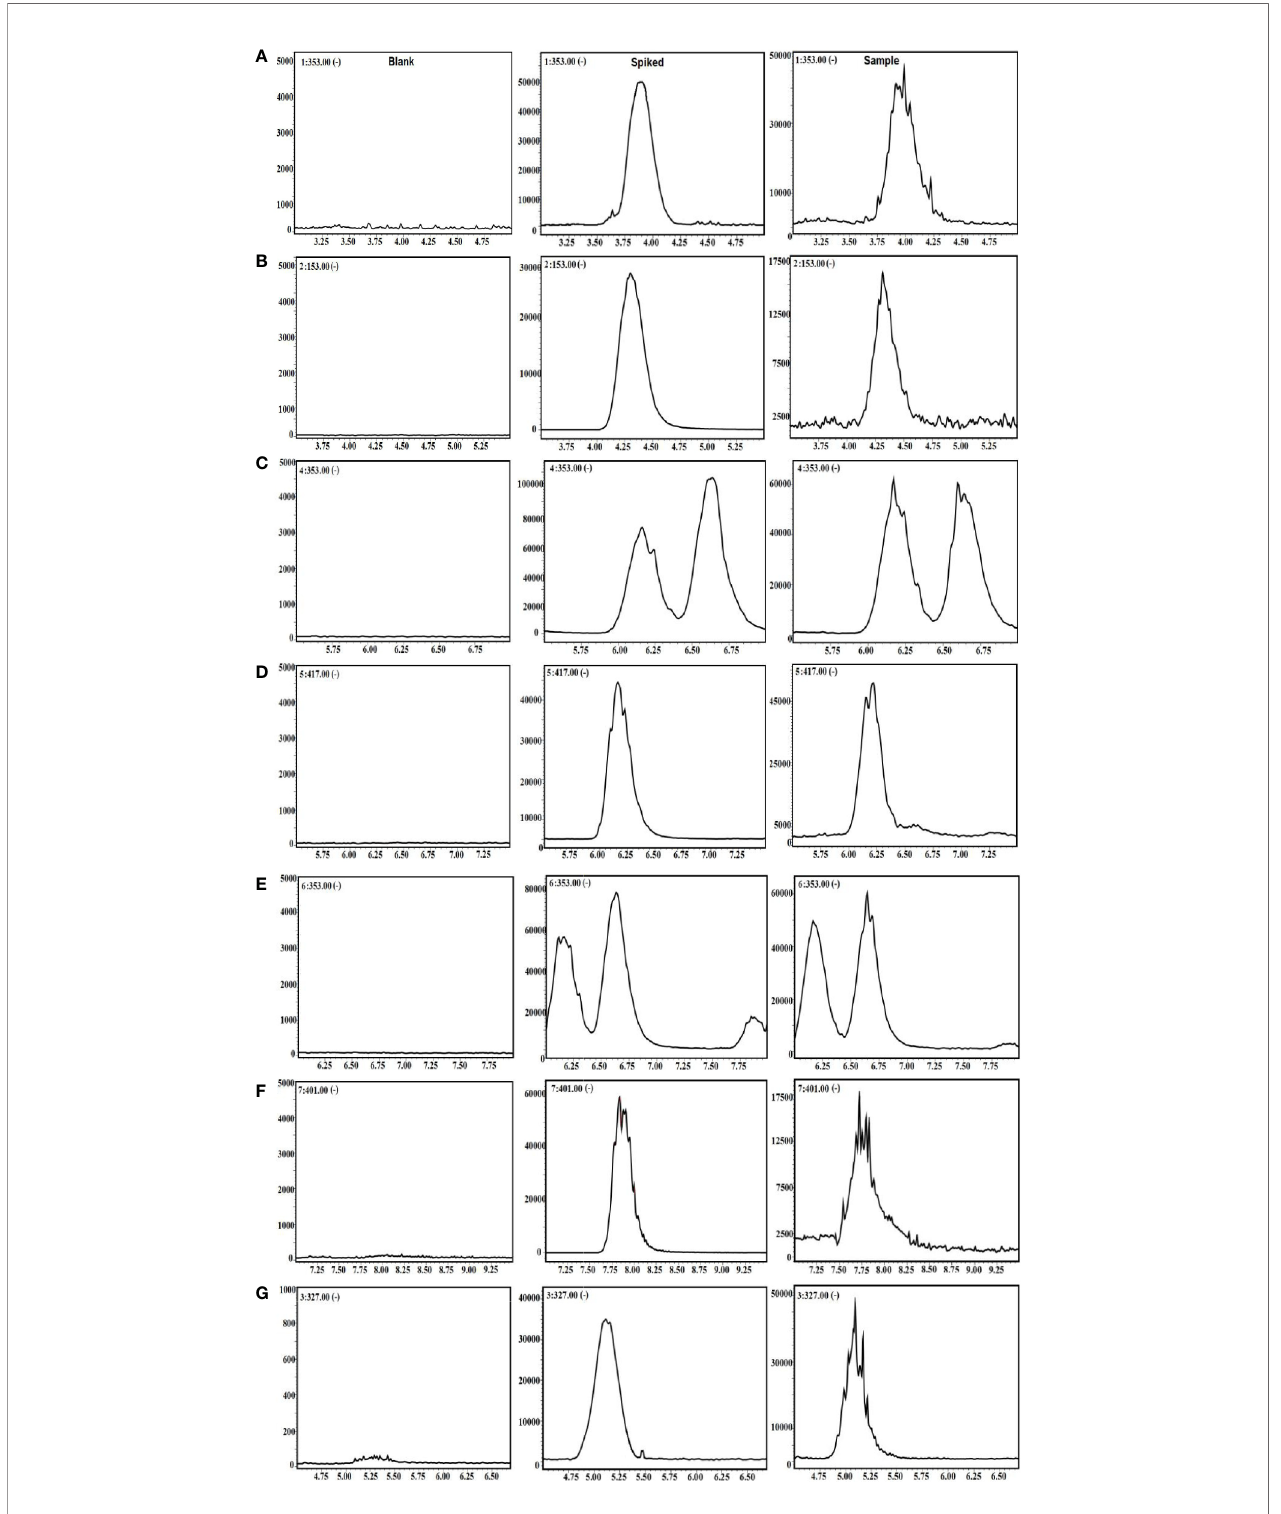
FIGURE 1 | The selective ion monitoring (SIM) chromatograms of 6 compounds and internal standard (IS) in negative mode. (A) 5-CQA; (B) PCA; (C) 3-CQA; (D) EB; (E) 4-CQA; (F) GPS; and (G)